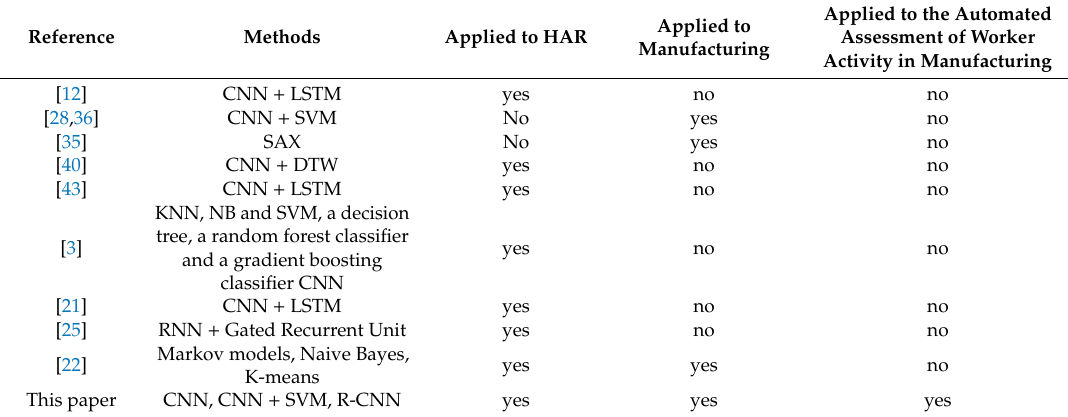
Table 1. New contributions of the approach to comparing the proposed approach with the closest related models in HAR, as applied to